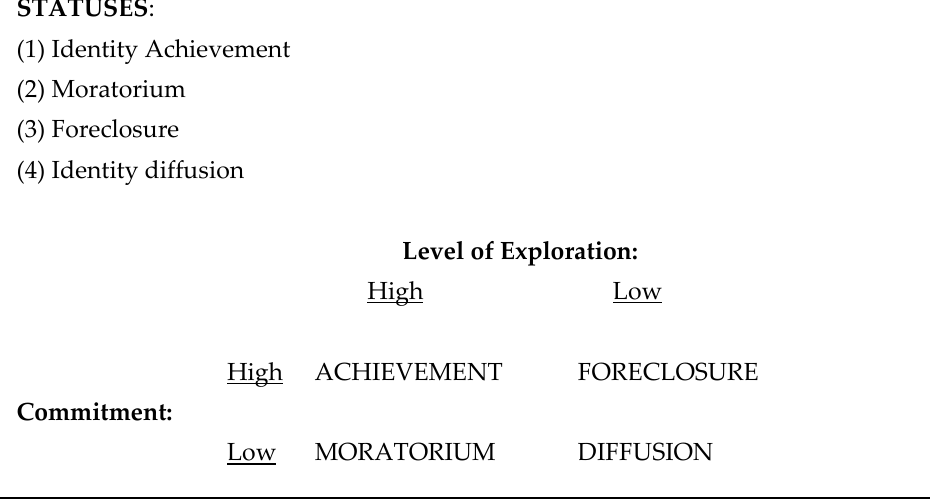
Figure 1. Identity statuses (Marcia 2009, p. 672).